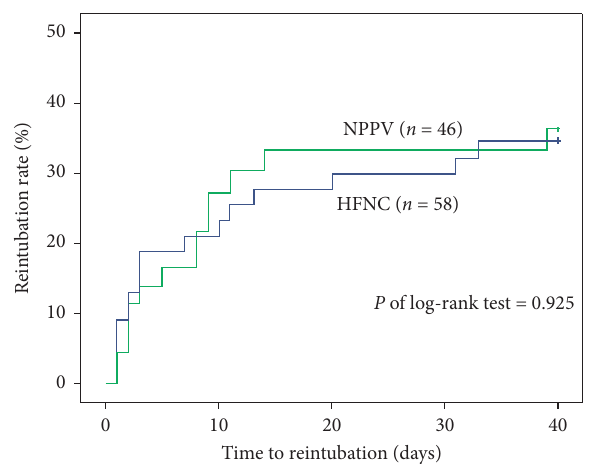
Figure 3: Kaplan–Meier plot of time to reintubation. HFNC, high- flow nasal cannula; NPPV, noninvasive positive pressure